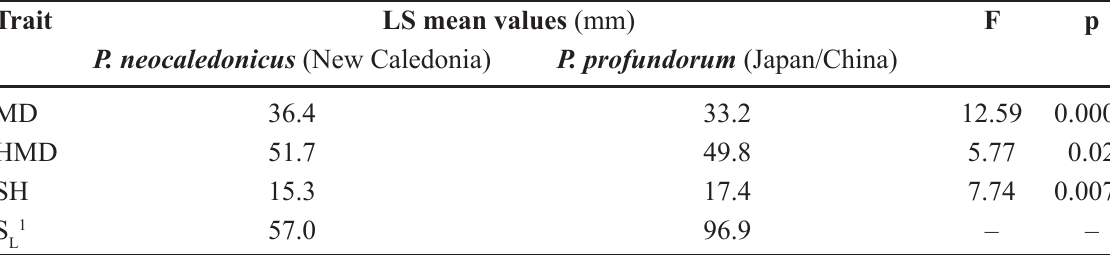
Table 3. Comparison between morphometric parameters for P. neocaledonicus sp. nov. (N = 28) and P. profundorum (Kuroda, 1956) (N = 26): Least-squares means and ANCOVA results.